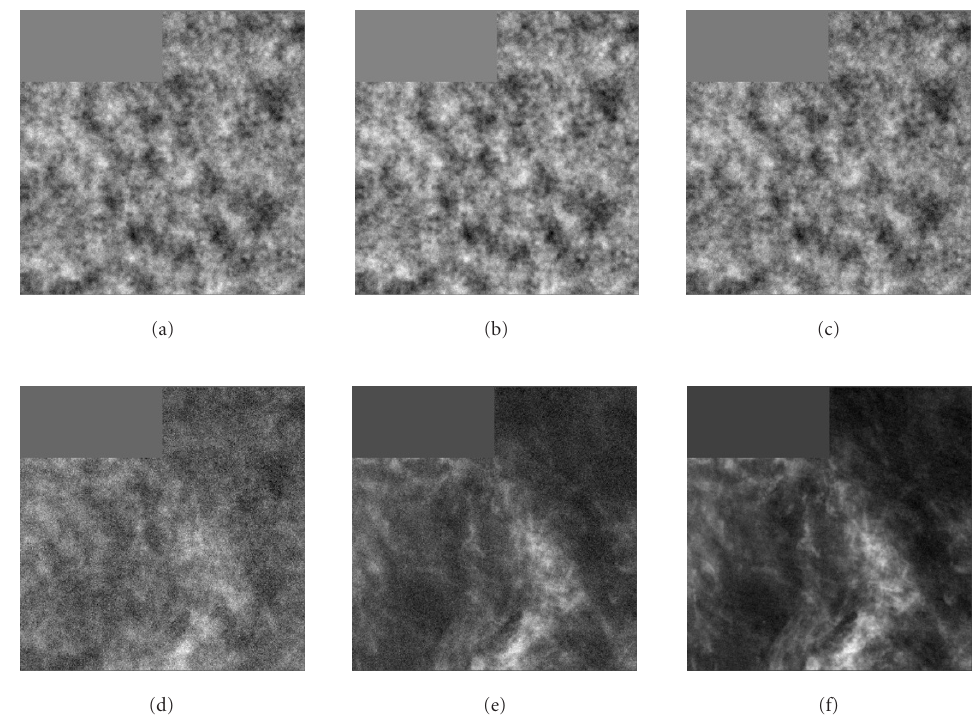
Figure 3: Simulated observation maps based on the templates shown in Figure 2 and the mixing matrix in Table 1 for the nominal Planck HFI noise levels.